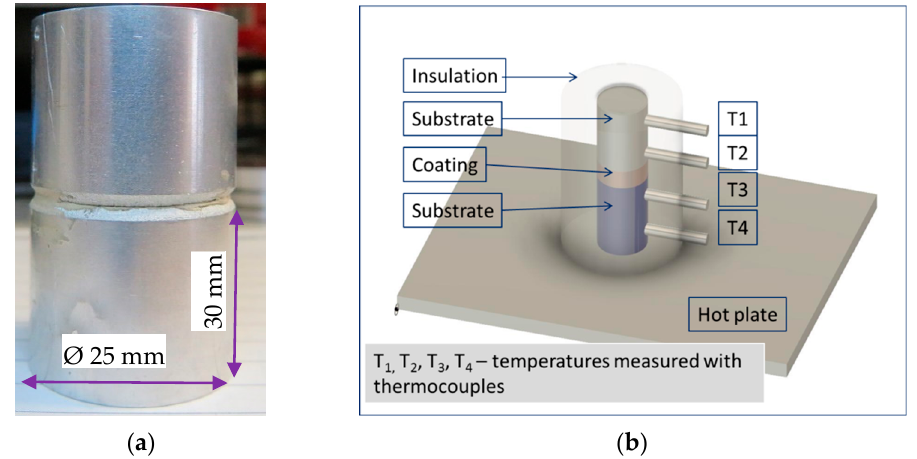
Figure 2. Experimental details. ( a ) Samples with TBCs attached by silver paint; ( b ) the hot plate experimental setup with the positions of the thermocouples.